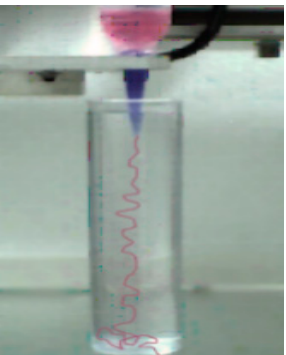
Figure A1. Formation of spiral curl of alginate hydrogel fiber.